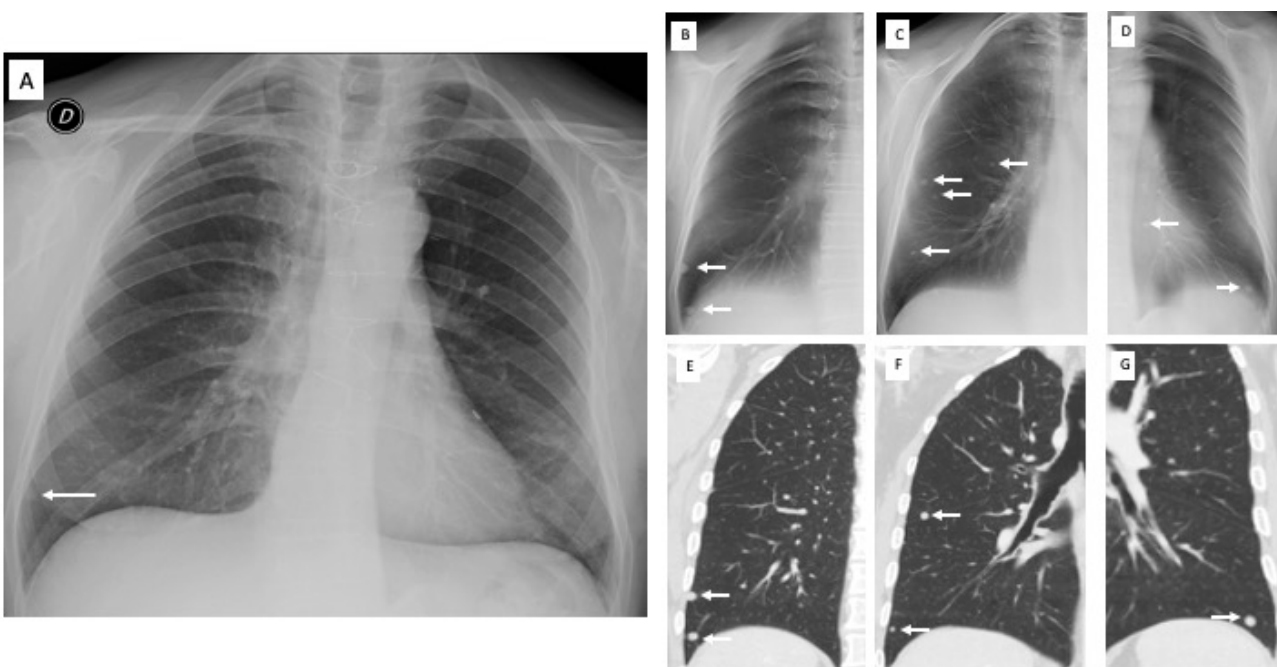
Figure 2. Pre-operative X-ray for colorectal carcinoma of a 56-year-old man. ( A ) Posteroanterior chest radiography in the upright position shows one suspected pulmonary nodule in the right lung base (arrow). ( B – D ) Digital tomosynthesis images confirm the previous nodule and identifies additional nodules (arrows) in both lungs, subsequently confirmed by CT ( E – G ).